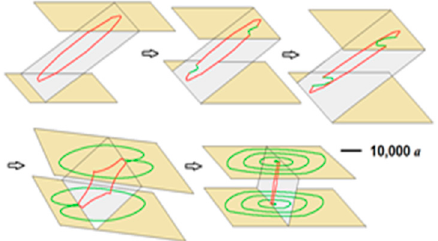
Figure 9. Discrete dislocation dynamics simulation of cross-slip of pyramidal Shockley loops on basal planes [56] .